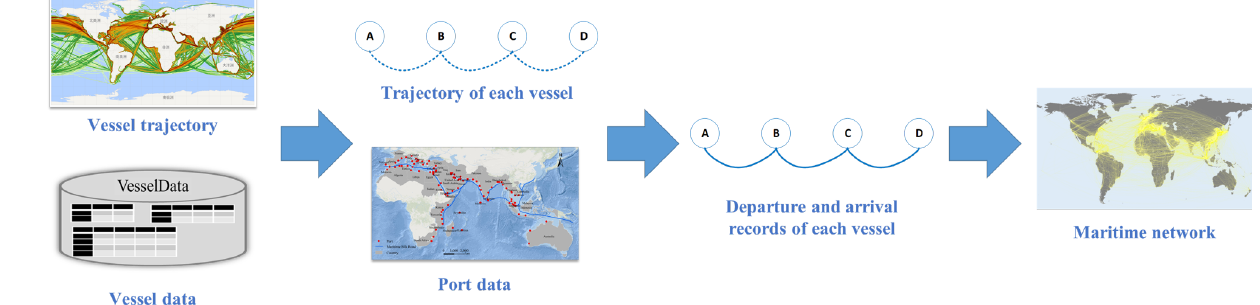
Figure 6. Sketch map of a maritime network